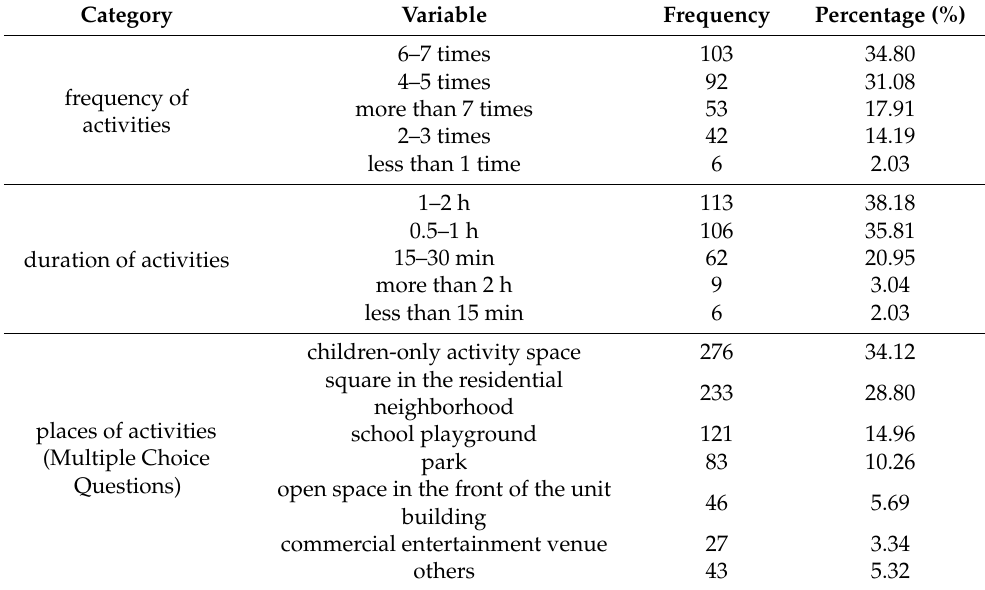
Table 3. Statistics on the characteristics of